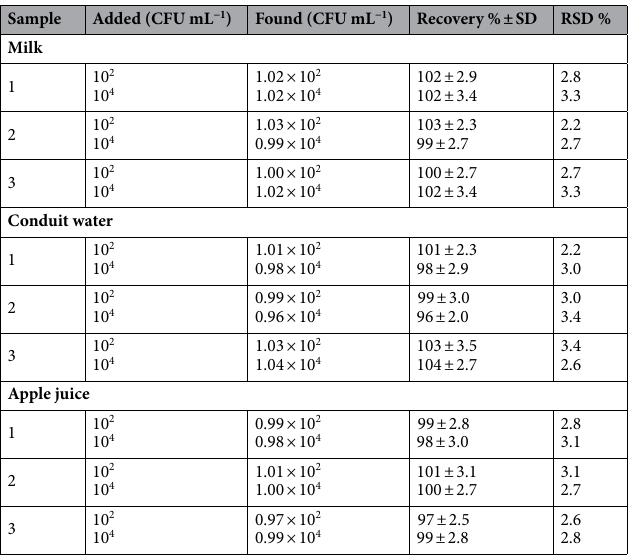
Table 2. Applications of MIP-apt-AuNPs@ Fe 3 O 4 /GCE for the determination of S. aureus in milk, conduit water, and apple juice samples.